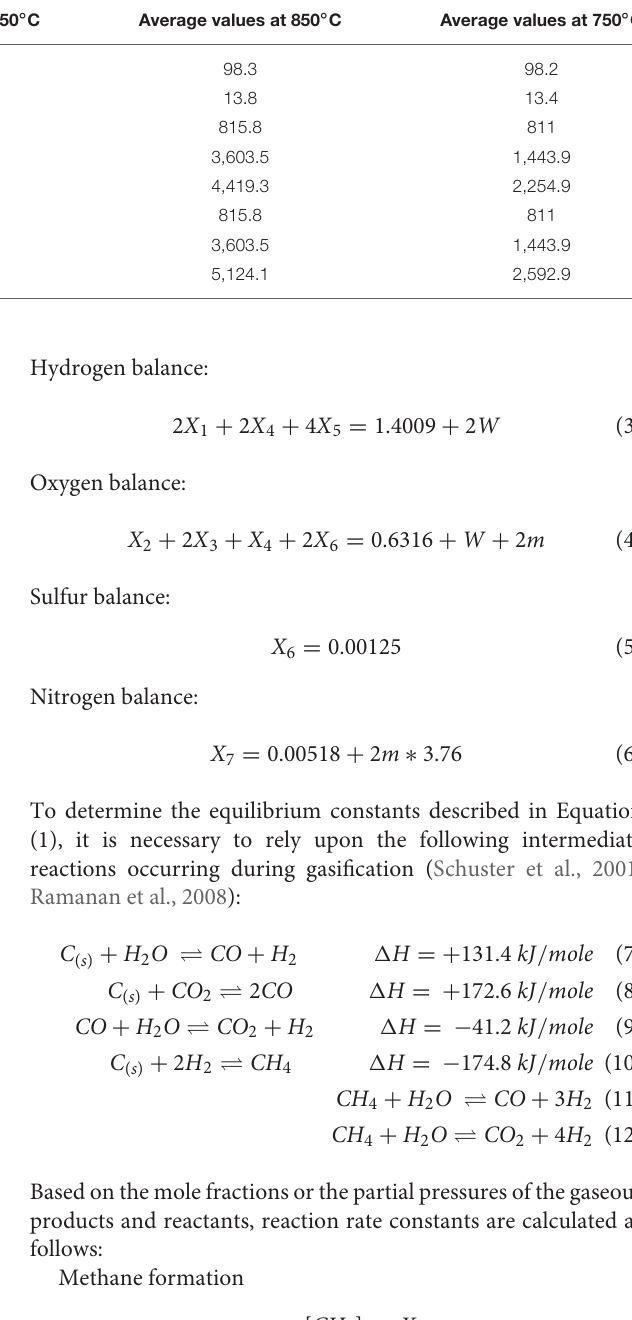
TABLE 2 | Tar collected at 950, 850, and 750 ◦